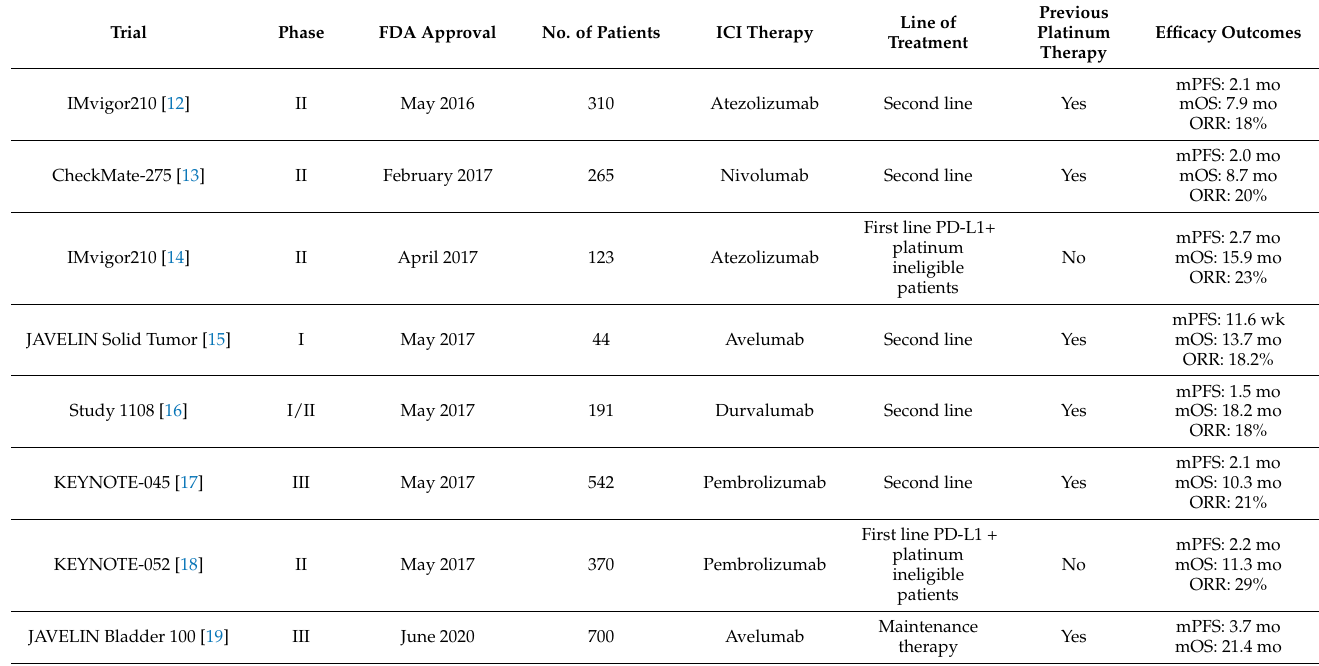
Table 1. Currently approved ICIs administered in urothelial bladder